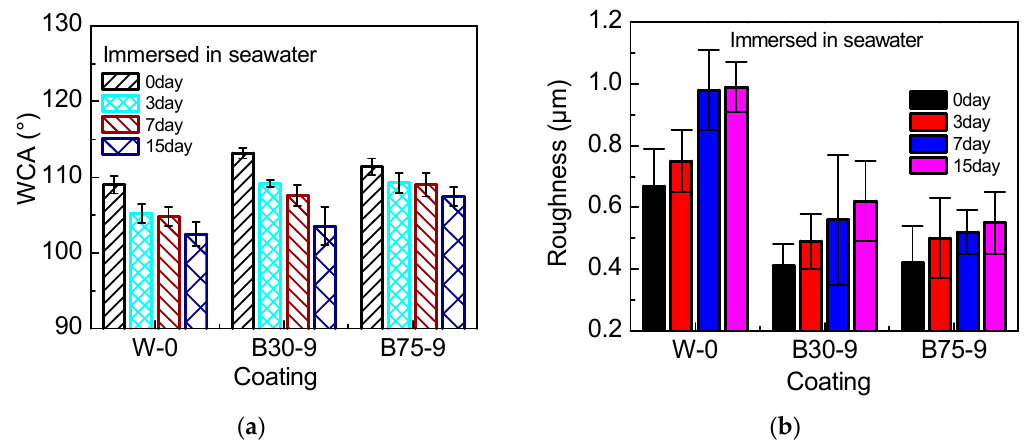
Figure 9. The relationship between immersion time and WCA ( a ), roughness ( b ).